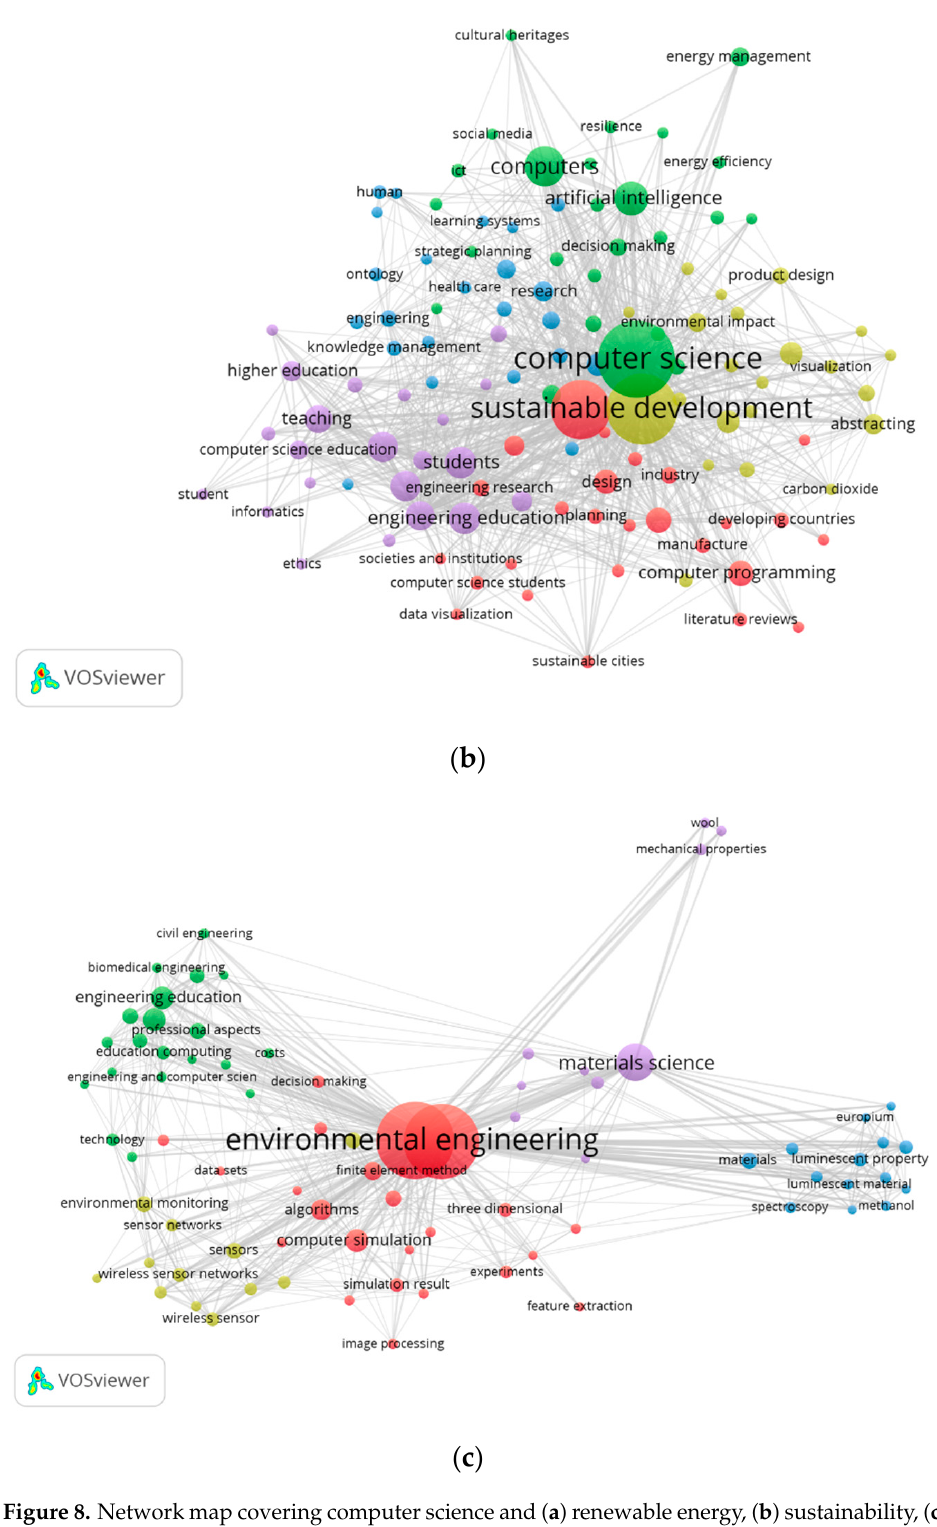
Figure 8. Network map covering computer science and ( a ) renewable energy, ( b ) sustainability, ( c ) the environmental engineering research subdomains, 2020–2021 (data source: Scopus (downloaded on 7 April 2021); copyright: Elsevier B.V.; graphics according to Kamada-Kawai layout).